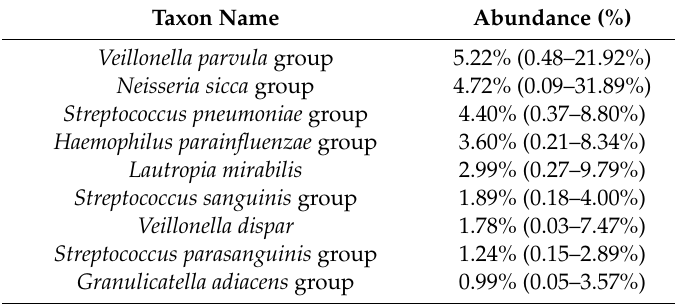
Figure 2. Heat map constructed from whole reads from 13 subjects. Table 1. A list of the bacteria found in samples from all thirteen Table 1. A list of the bacteria found in samples from all thirteen subjects.